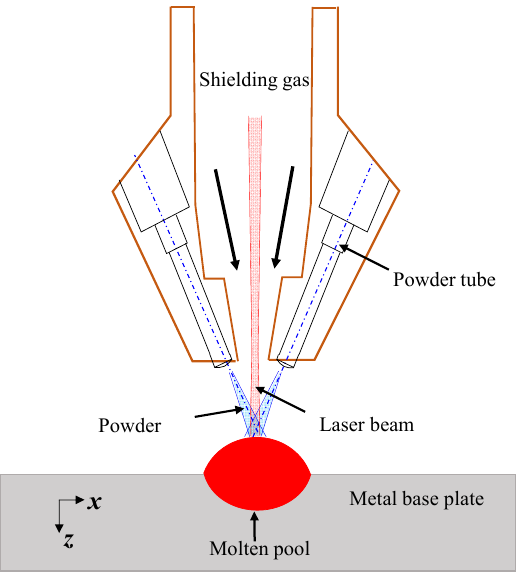
Figure 3. Schematic diagram of molten pool formation.